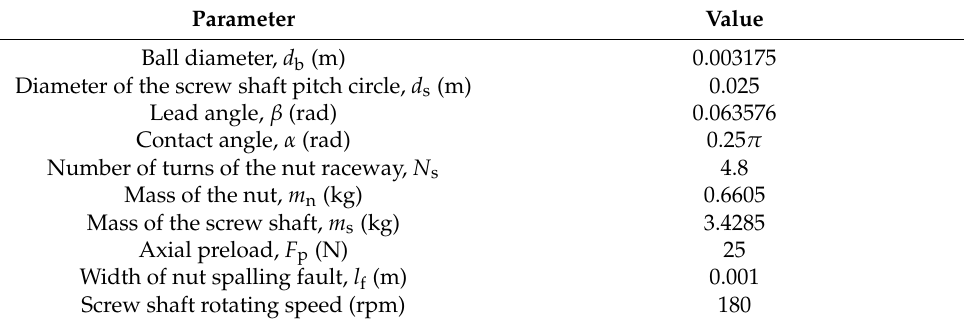
Table 1. Main parameters of the normal/faulty simulation